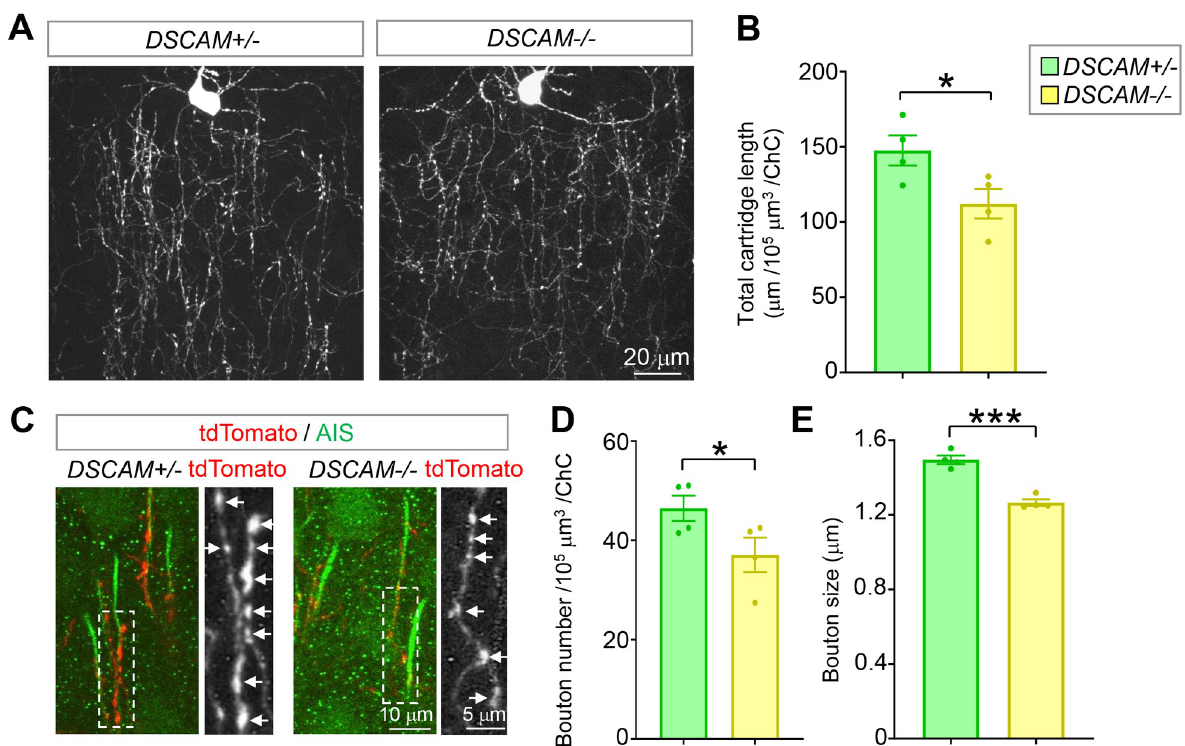
Fig 5. Loss of DSCAM impairs the growth of ChC axon cartridges and boutons. ( A ) Representative images of single ChCs in layer II/III of ACC. Shown are ChCs of DSCAM 2j/+ (+/ − ) and DSCAM 2j/2j ( − / − ) mice at P28. All ChC images in this paper are from this brain region of P28 mice. Scale bar, 20 μ m. ( B ) Quantification of the total cartridge length (A). For each ChC, all axon cartridges (approximately 15–40) innervating the AIS of PyNs in a volume of 120 μ m (length) × 80 μ m (width) × 30 μ m (thickness) with the ChC cell body in the top middle were analyzed (S6 Fig). For each mouse, 4–6 ChCs were analyzed, and 4 DSCAM +/ − and 4 DSCAM − / − mice were analyzed. ( C ) Representative images of ChC axon cartridges innervating the AIS of PyNs. Cartridges of single ChCs were labeled with tdTomato (Red). The AIS of PyNs were labeled by anti-phospho-I κ B (pI κ B, green). The arrows point to presynaptic boutons of ChCs in the boxed regions. ( D , E ) Quantification of bouton number ( D ) and size ( E ). For each ChC, all boutons in axon cartridges that innervate AIS in the defined volume (S6 Fig) were analyzed for bouton numbers; boutons in the 10 cartridges nearest to the cell body were analyzed for bouton sizes. In each mouse, 4–6 ChCs were analyzed. A total of 4 DSCAM +/ − and 4 DSCAM − / − mice were analyzed. Each dot represents 1 mouse. Student t test * : p < 0.05; *** : p < 0.001. The data underlying this Figure can be found in https://doi.org/10.5281/zenodo.7714234. ACC, anterior cingulate cortex; AIS, axon initial segment; ChC, chandelier cell; DSCAM, Down syndrome cell adhesion molecule; PyN, pyramidal neuron; P28, postnatal day